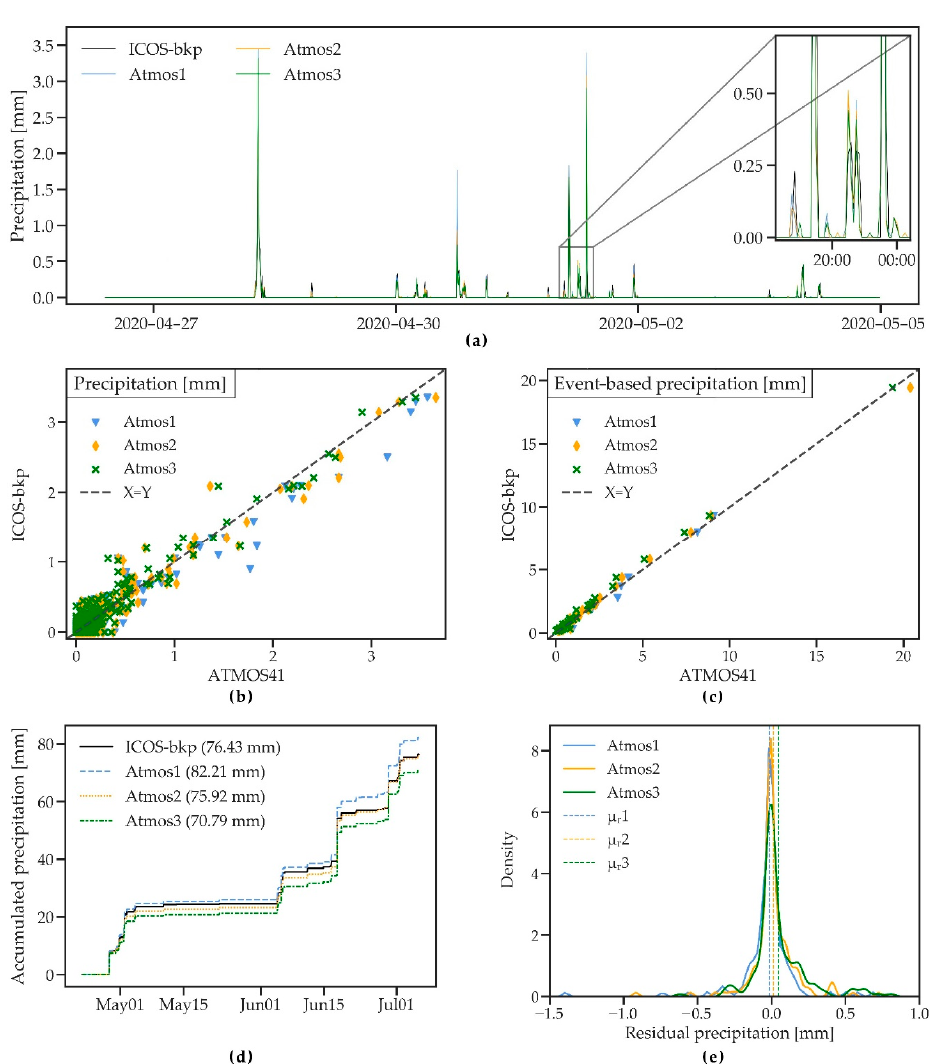
Figure 5. ( a ) A short time series of precipitation measured by three ATMOS41 weather stations and the ICOS-bkp station from 28 April to 4 May 2020. ( b , c ) Scatterplots of 10 min precipitation and event-based precipitation sum for the three ATMOS41 stations vs. the reference station. ( d ) Cumulative precipitation measured by the three ATMOS41 weather stations and the reference station for the whole time series (numbers in parentheses refer to total precipitation amount). ( e ) Probability density functions of the residual hourly precipitation sum. Dashed lines show the mean of residuals ( μ r ).